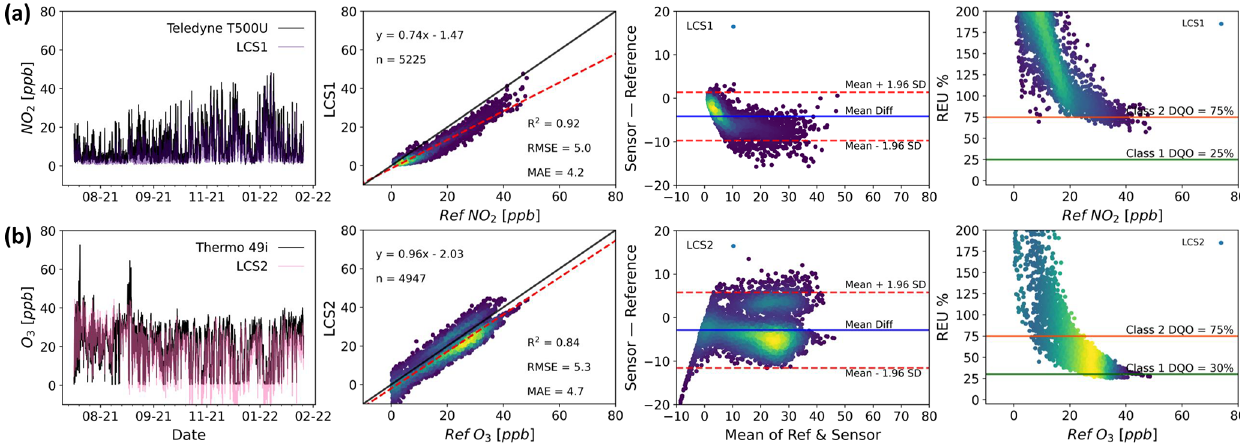
Figure 5. Time series (first column), regression (second column), Bland–Altman (third column) and REU (fourth column; NO 2 Class 1 DQO = 25% and Class 2 DQO = 75% ; O 3 Class 1 DQO = 30% and Class 2 DQO = 75%) plots for NO 2 (a) and O 3 (b) measurements by two LCS systems of different brands in the same location and time span (Manchester Supersite, July 2021 to February 2022; time resolution 1h). All but the time series plots have been coloured by data density. (Darker colours denote lower density and lighter colours denote higher